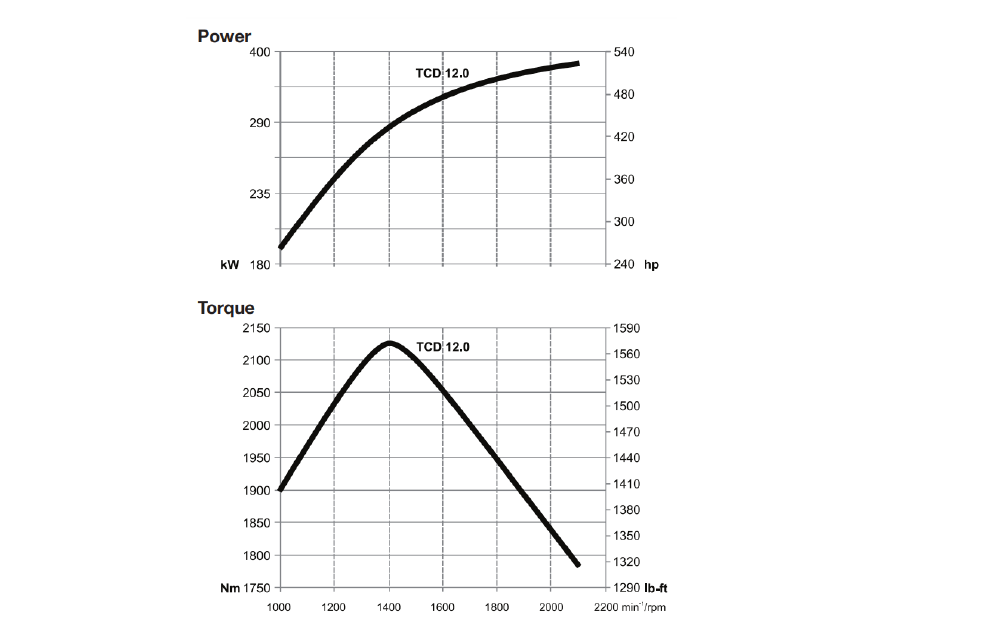
Figure 2. The characteristics of the output power and torque by the rotation speed for DEUTZ TCD 12.0 V6 diesel engine